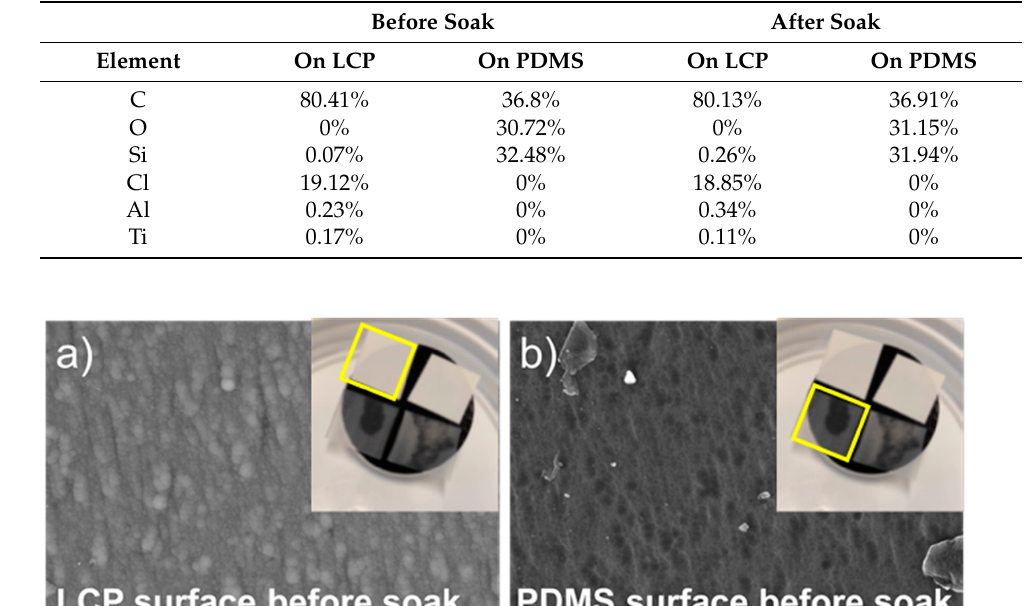
Table 3. Elemental analysis of the LCP and silicone (PDMS) surfaces after T-peel test using EDX.